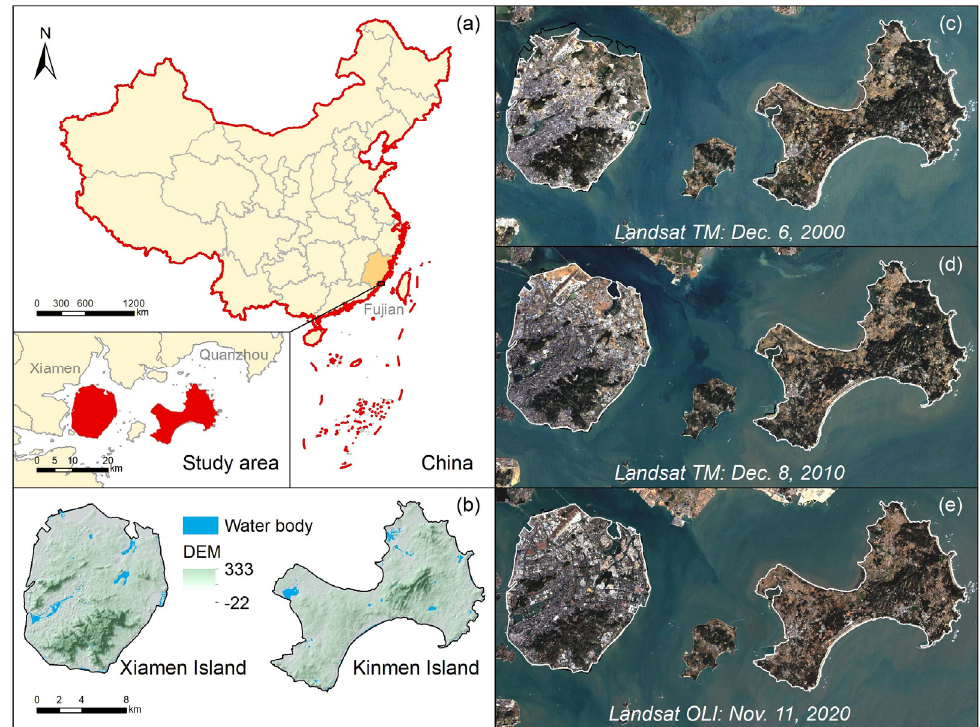
Figure 1. Geographical location of the study area and the presentation of geographical data. ( a ) Location of the study area in China; ( b ) Comparison of topography features between Xiamen Island and Kinmen Island based on DEM; ( c – e ) Decadal spatial distribution of the land surface of the study area.